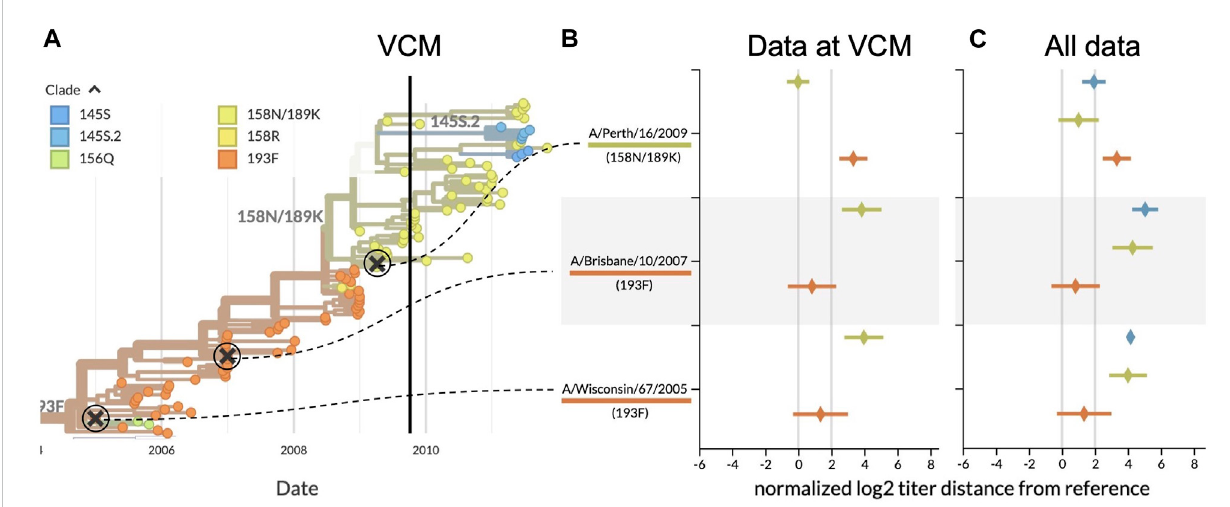
FIGURE 3 SerologicalanalysisofH3N2cladesaroundthetimeofthesouthernhemispherevaccinecompositionmeeting(VCM)forthe2010in fl uenzaseason. (A) Phylogenetic tree summarizing the clades circulating before and after the VCM in September 2009. At the time of the VCM, clade 158N/189K (yellowish green) was dominant, and A/Perth/16/2009 was the vaccine candidate from this clade. A/Brisbane/10/2007 (clade 193F) had been the southern hemisphere vaccine in 2008 and 2009 and A/Wisconsin/67/2005 (clade 193F) had been the vaccine in 2007. (B) HI titers for three vaccine candidates against testviruses fromthetwolargestrecentclades, usingonlydata availableprior tothe fi naldecision from theVCM(25September2009). HI titers greater than 2log 2 indicate the inability of previous vaccines to cover viruses from the most recent clades. (C) Same as (B) but including test virusesandHImeasurementscollectedaftertheVCMfor158N/189KandthelargestnewcladewithHA1:145S,145S.2.WithmeanHItiterslessthan2log 2 , A/Perth/16/2009 covered 158N/189K viruses better than the previous